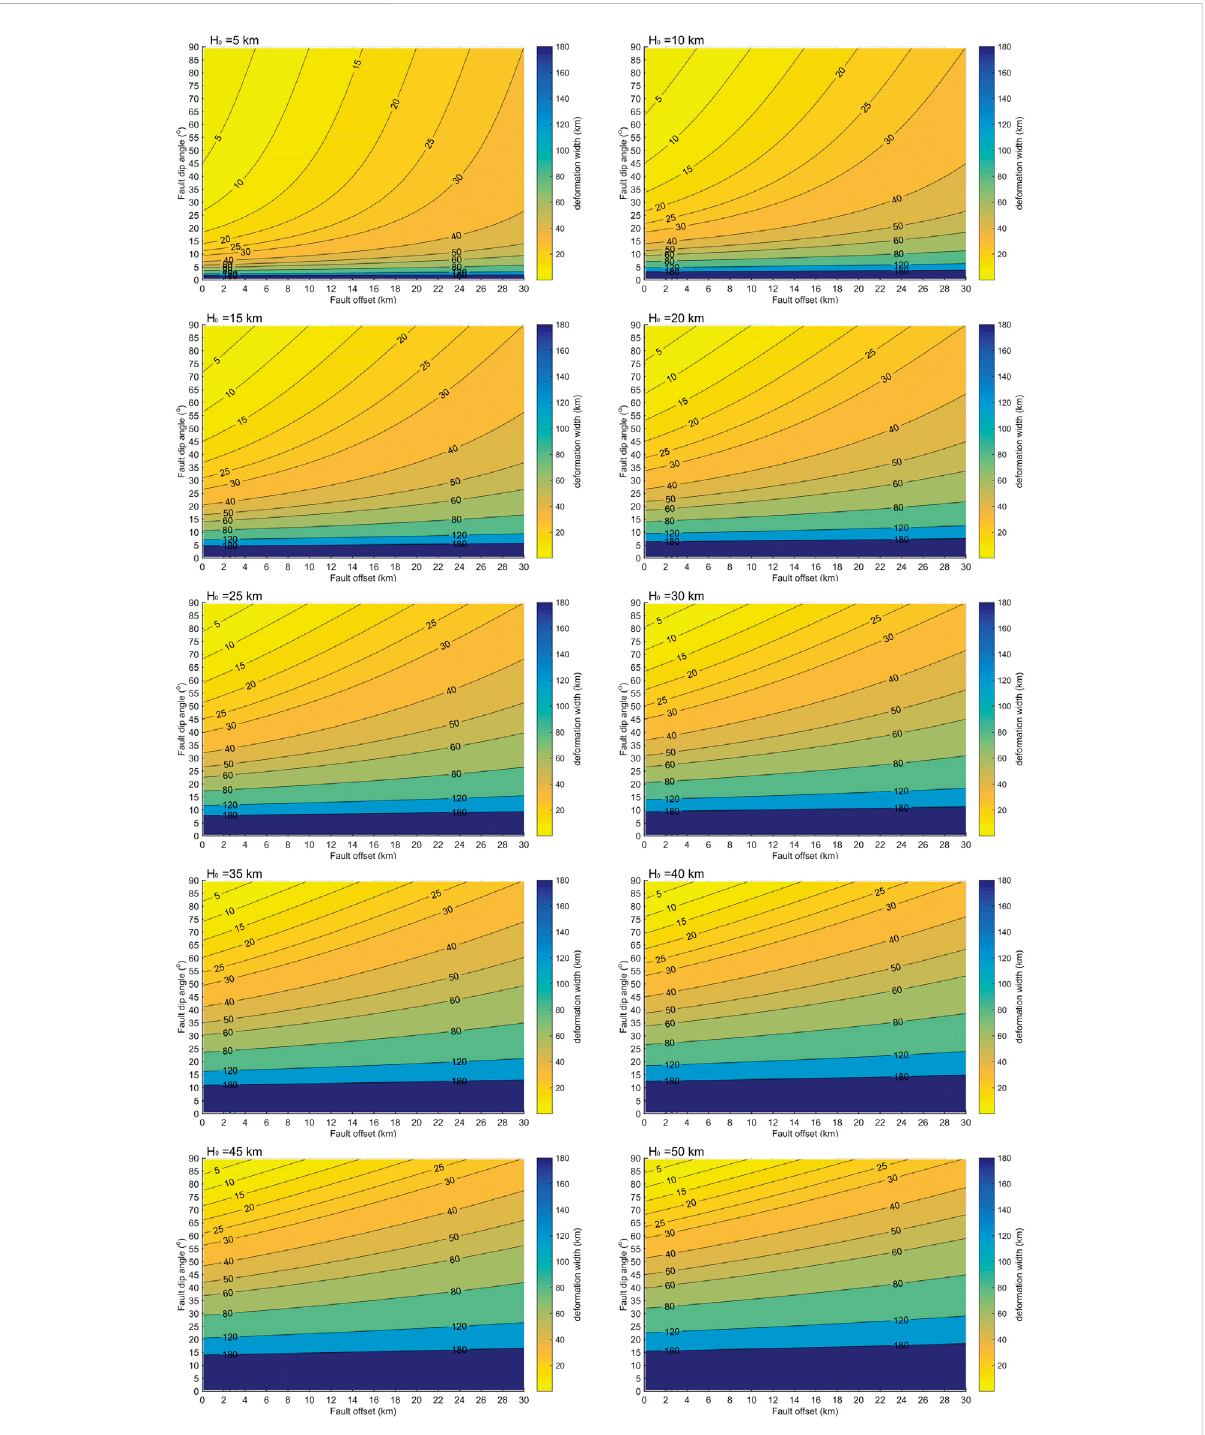
FIGURE 4 Comparison ofdeformationwidth (W)contour-plotsintheparameter domain space(dip-offset)areshown atH 0 =5 km,10 km,15 km,20 km, 25 km, 30 km, 35 km, 40 km, 45 km, and 50